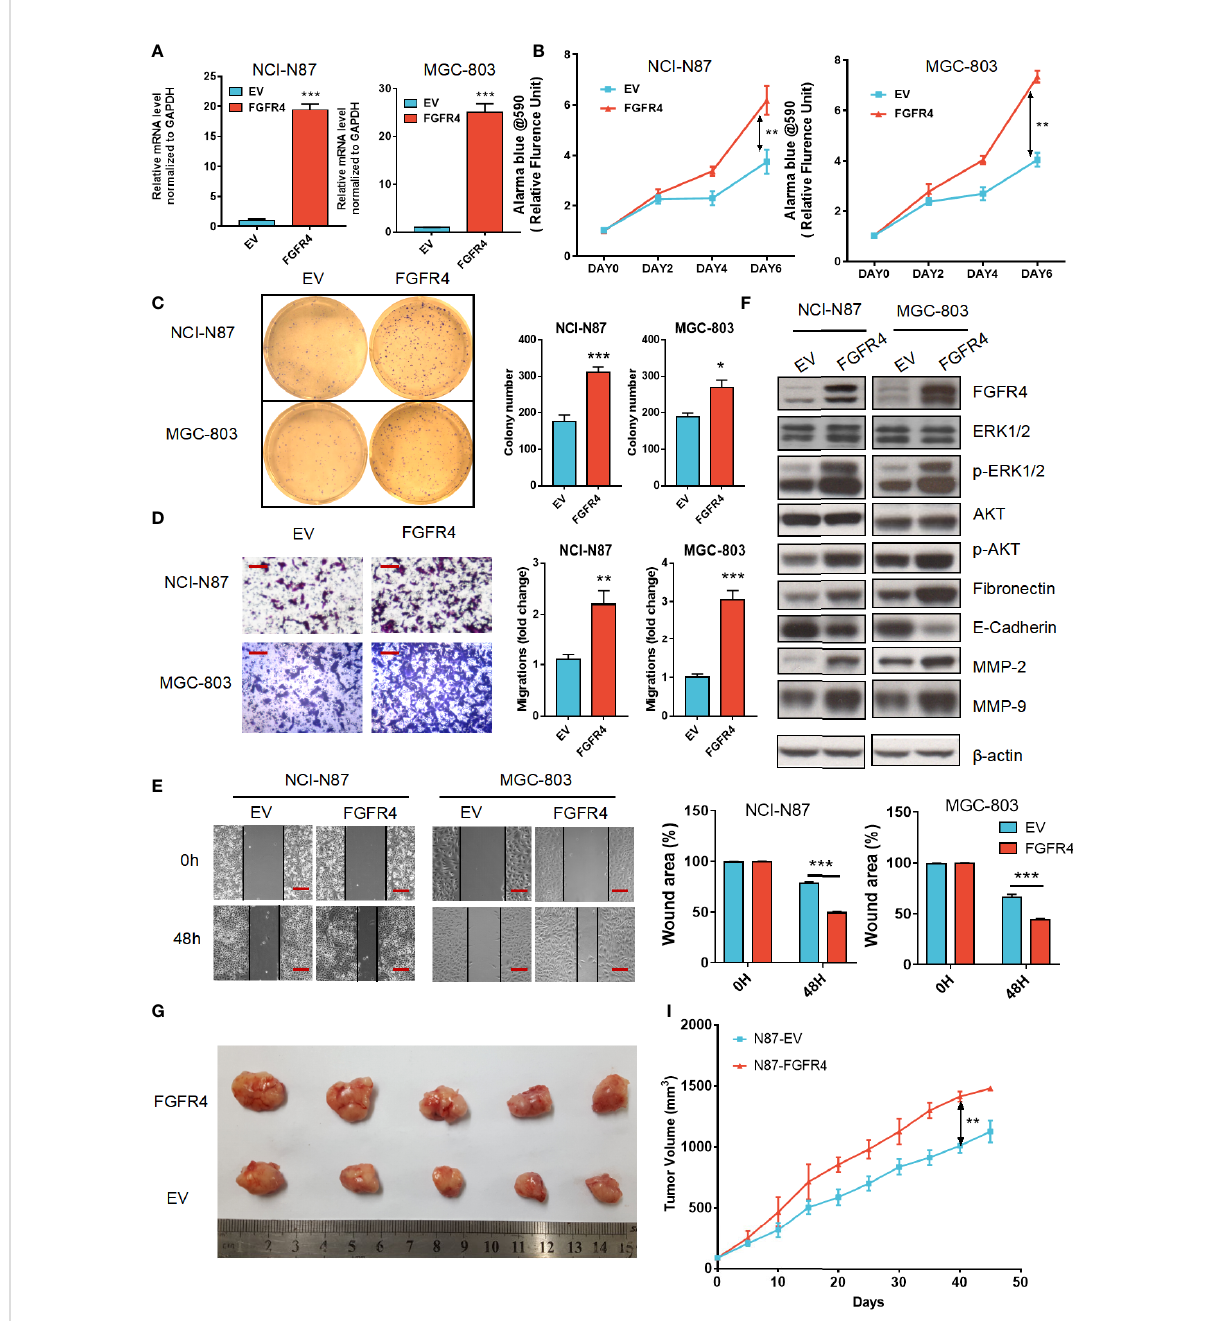
FIGURE 5 FGFR4 overexpression in GC cells exhibits a tumor progression effect. (A) FGFR4 mRNA levels were detected by qRT-PCR in NCI-N87 (A) and MGC-803 cells transfected with EV (control plasmid) and FGFR4 (p-HAGE -FGFR4). (B) FGFR4 overexpression promoted cell proliferation in GC NCI-N87 and MGC-803 cells, respectively. (C) FGFR4 overexpression improved the colony formation ability of GC cells. (D, E) Cell invasion and migration capacity were measured by the Transwell invasion assay (D) (scale bar, 100 m m) and Scratch assay (E) (scale bar, 200 m m). (F) N87-EV, N87-FGFR4, MGC803-EV, and MGC803-FGFR4 cells were collected with lysates subject to immunoblotting. (G) Representative images of nude mouse subcutaneous tumors for N87-EV and N87-FGFR4 cell lines. (I) Tumor volume was measured at the indicated time points. Data represent the mean of three independent experiments. * p < 0.05, ** p < 0.01, *** p <0.001 student ’ s t-test; GC, gastric cancer; RT-PCR, real-time quantitative reverse transcription polymerase chain reaction; EV, empty